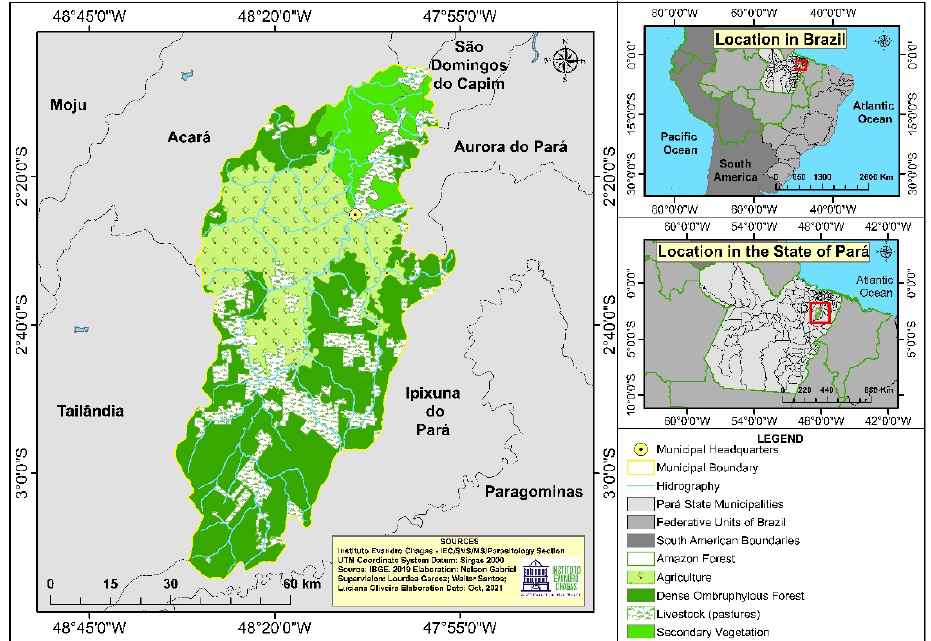
Figure 1. Location and vegetation map of Tomé-Açu, Pará, Amazon, Brazil.